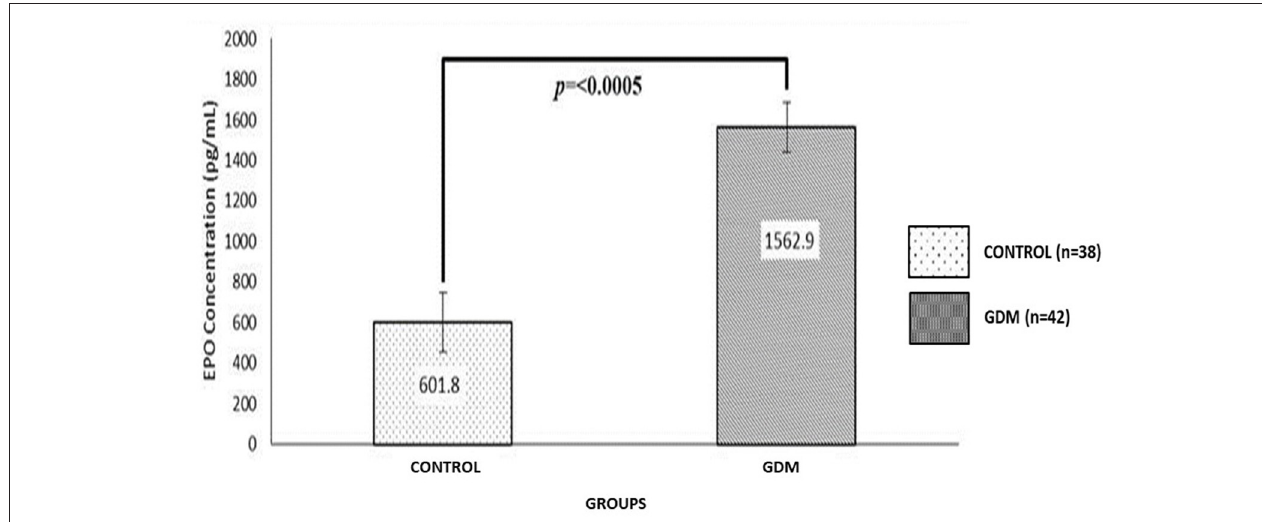
FIGURE 1 | Comparison of EPO UCB concentration (pgmol/mL) between GDM and Control groups. The EPO level was significantly higher in GDM as compared to the Control group ( p = < 0.0005).